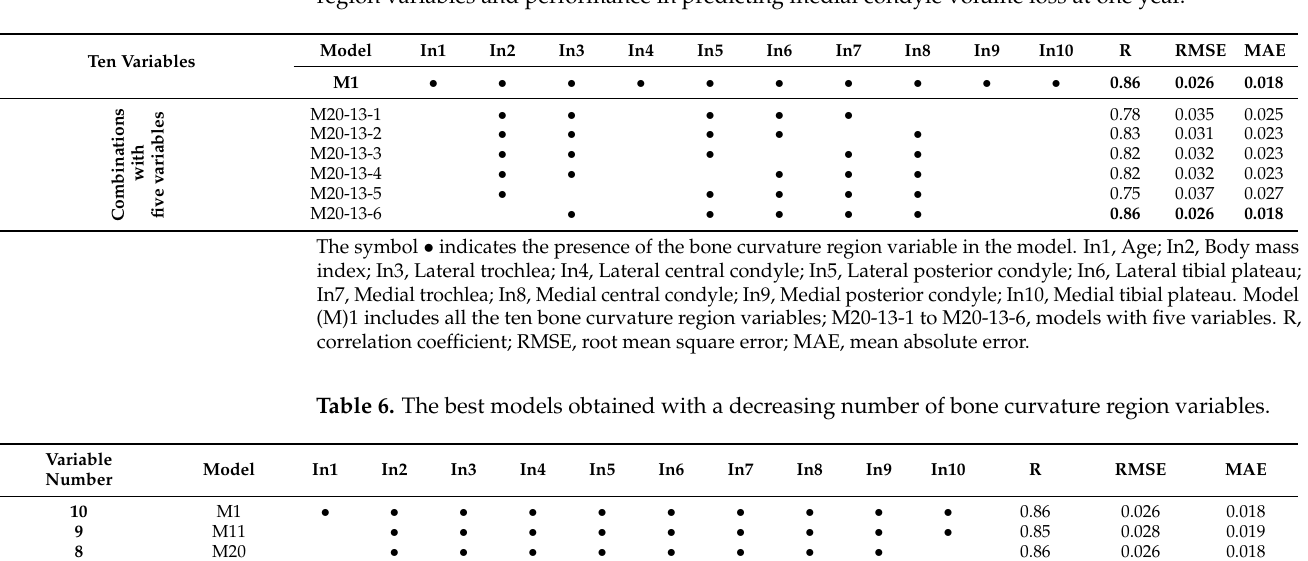
Table 5. Models in the systematic controllability variable reduction approach for five bone curvature region variables and performance in predicting medial condyle volume loss at one year.